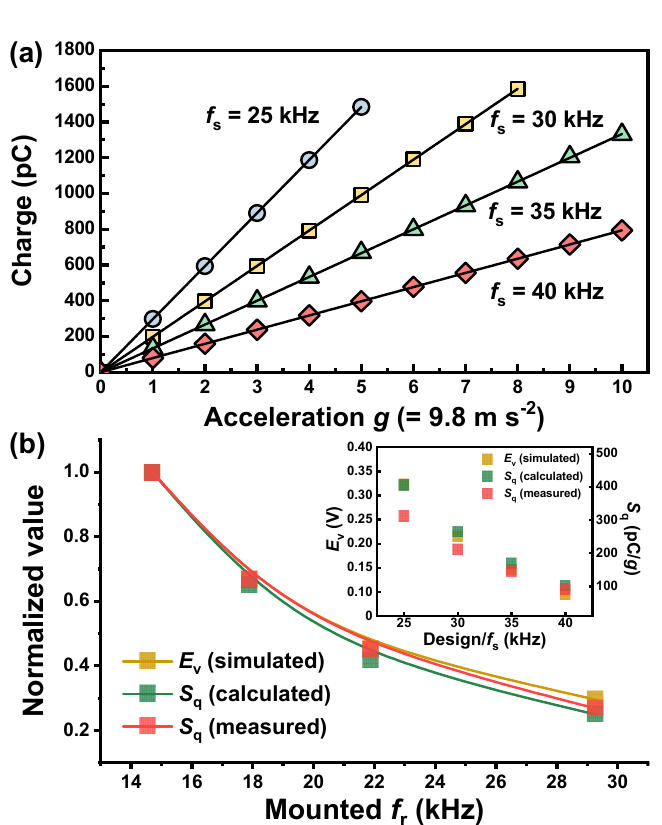
Figure 8. ( a ) Charge versus acceleration characteristics measured from accelerometer modules (test frequency = 159 Hz); ( b ) Variation of normalized values of E v , calculated and measured S q with fixed f r (inset shows design ‐ dependent E v and S q values).